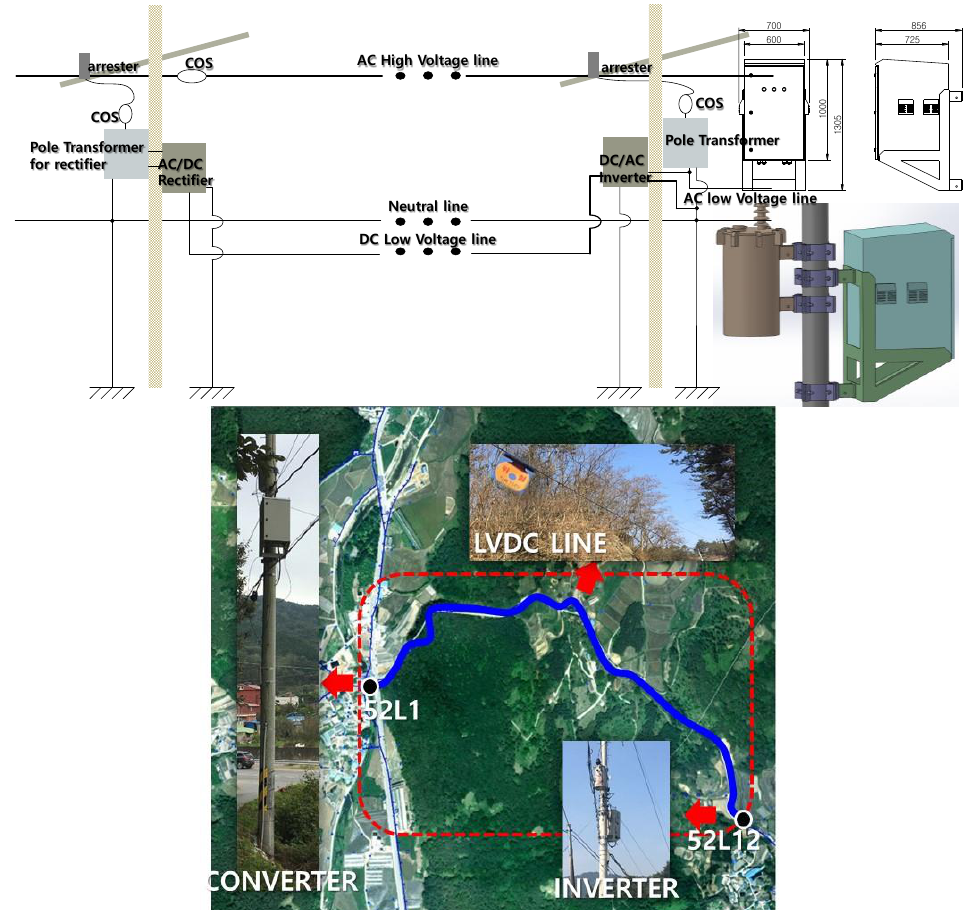
Figure 8. Configuration plan of the long-distance LVDC distribution demonstration site.